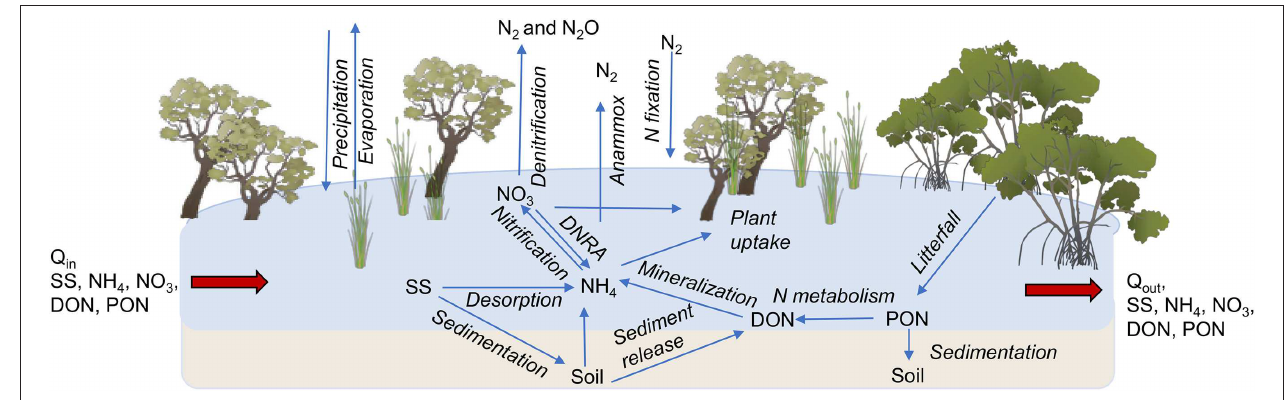
FIGURE 1 | Conceptual model of N fluxes during a flood in estuarine and palustrine wetlands in tropical Australia, which was used for the derivation of the numerical model.